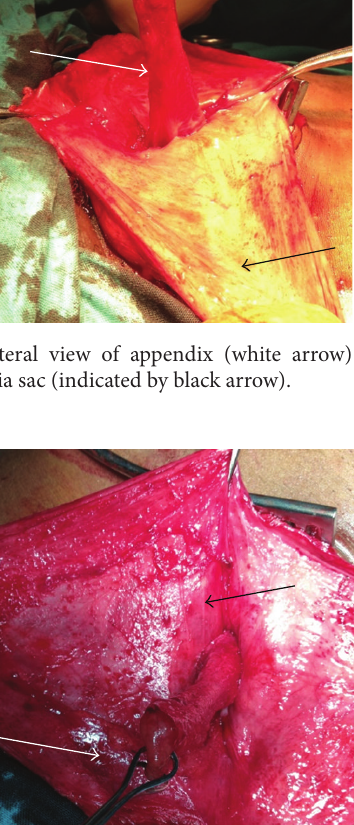
Figure 4: Contrast within left inguinal sac noted on decubitus positioning of the patient (indicated by black